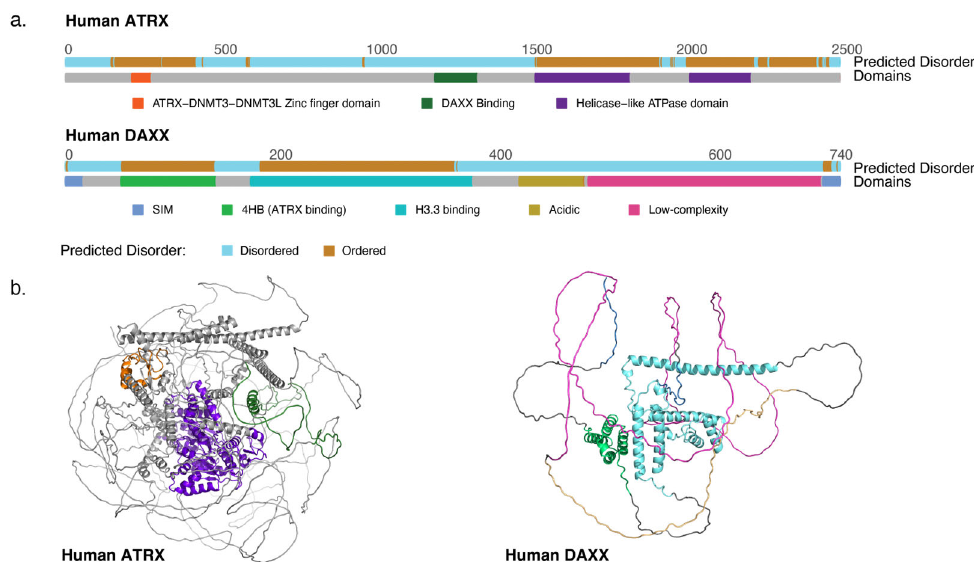
Figure 1. ( a ) Diagram of the ATRX and DAXX proteins outlining major domains and indicating Figure 1. (a) Diagram of the ATRX and DAXX proteins outlining major domains and predicted disordered regions. ( b ) AlphaFold models of ATRX and DAXX illustrating the largely indicating predicted disordered regions. (b) AlphaFold models of ATRX and DAXX il ‐ disordered nature of the proteins, with domains colored as in ( a ) lustrating the largely disordered nature of the proteins, with domains colored as in (a)